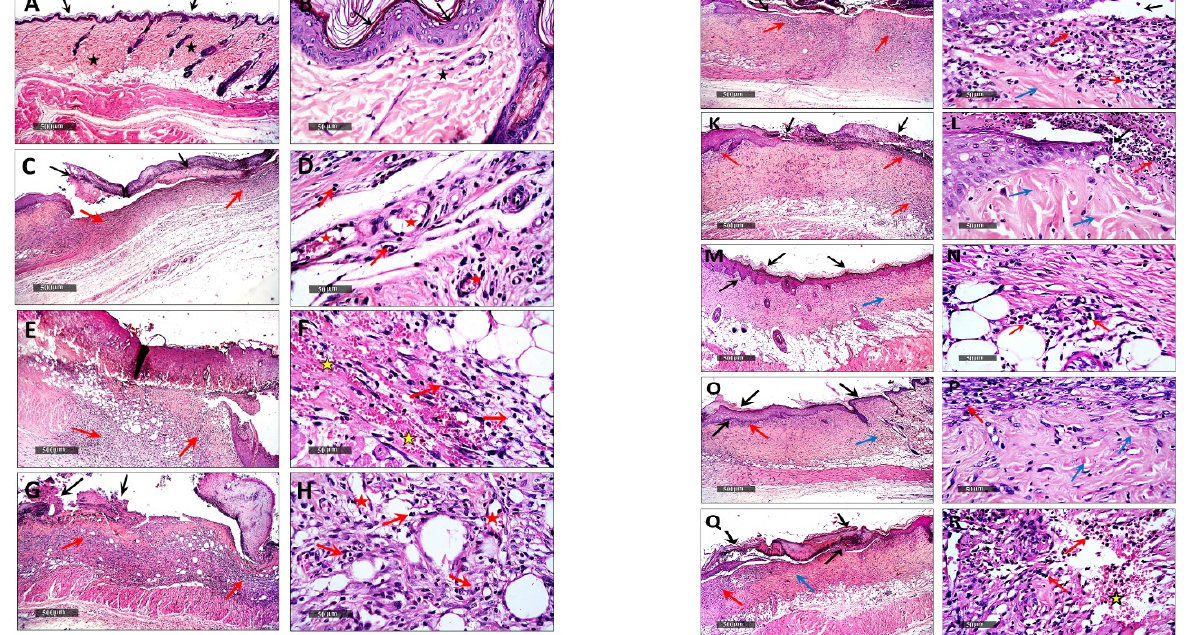
Figure 3. Demonstrating the light microscopic histopathological features of skin layers and wound healing process in different groups; ( A , B ): group I, ( C , D ): group II, ( E , F ): group III, ( G , H ): group IV, ( I , J ): group V, ( K , L ): group VI, ( M , N ): group VII ( O , P ): group VIII, ( Q , R ): group IX. Group codes are shown in Table 4. (H&E stain). Black arrow: Epidermal layer & wound gap. Star: intact skin dermis. Red arrow: Inflammatory cell infiltrates. Red star: congested subcutaneous blood vessels. Blue arrow: Dermal mature collagen fibers. Yellow star: dermal hemorrhagic